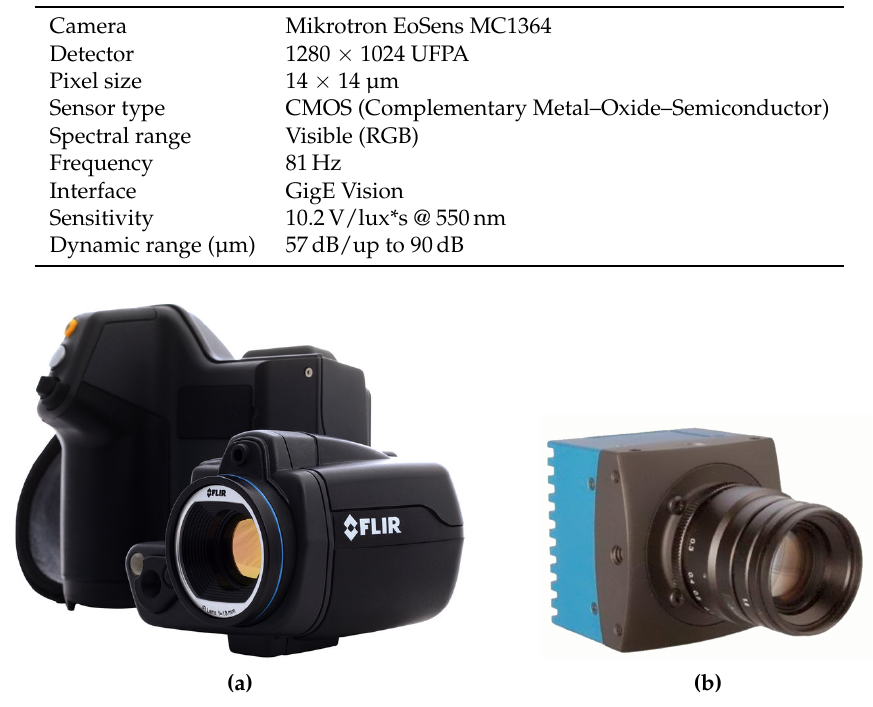
Figure 4. Cameras used in the experiments. ( a ) FLIR T450sc, ( b ) Mikrotron EoSens